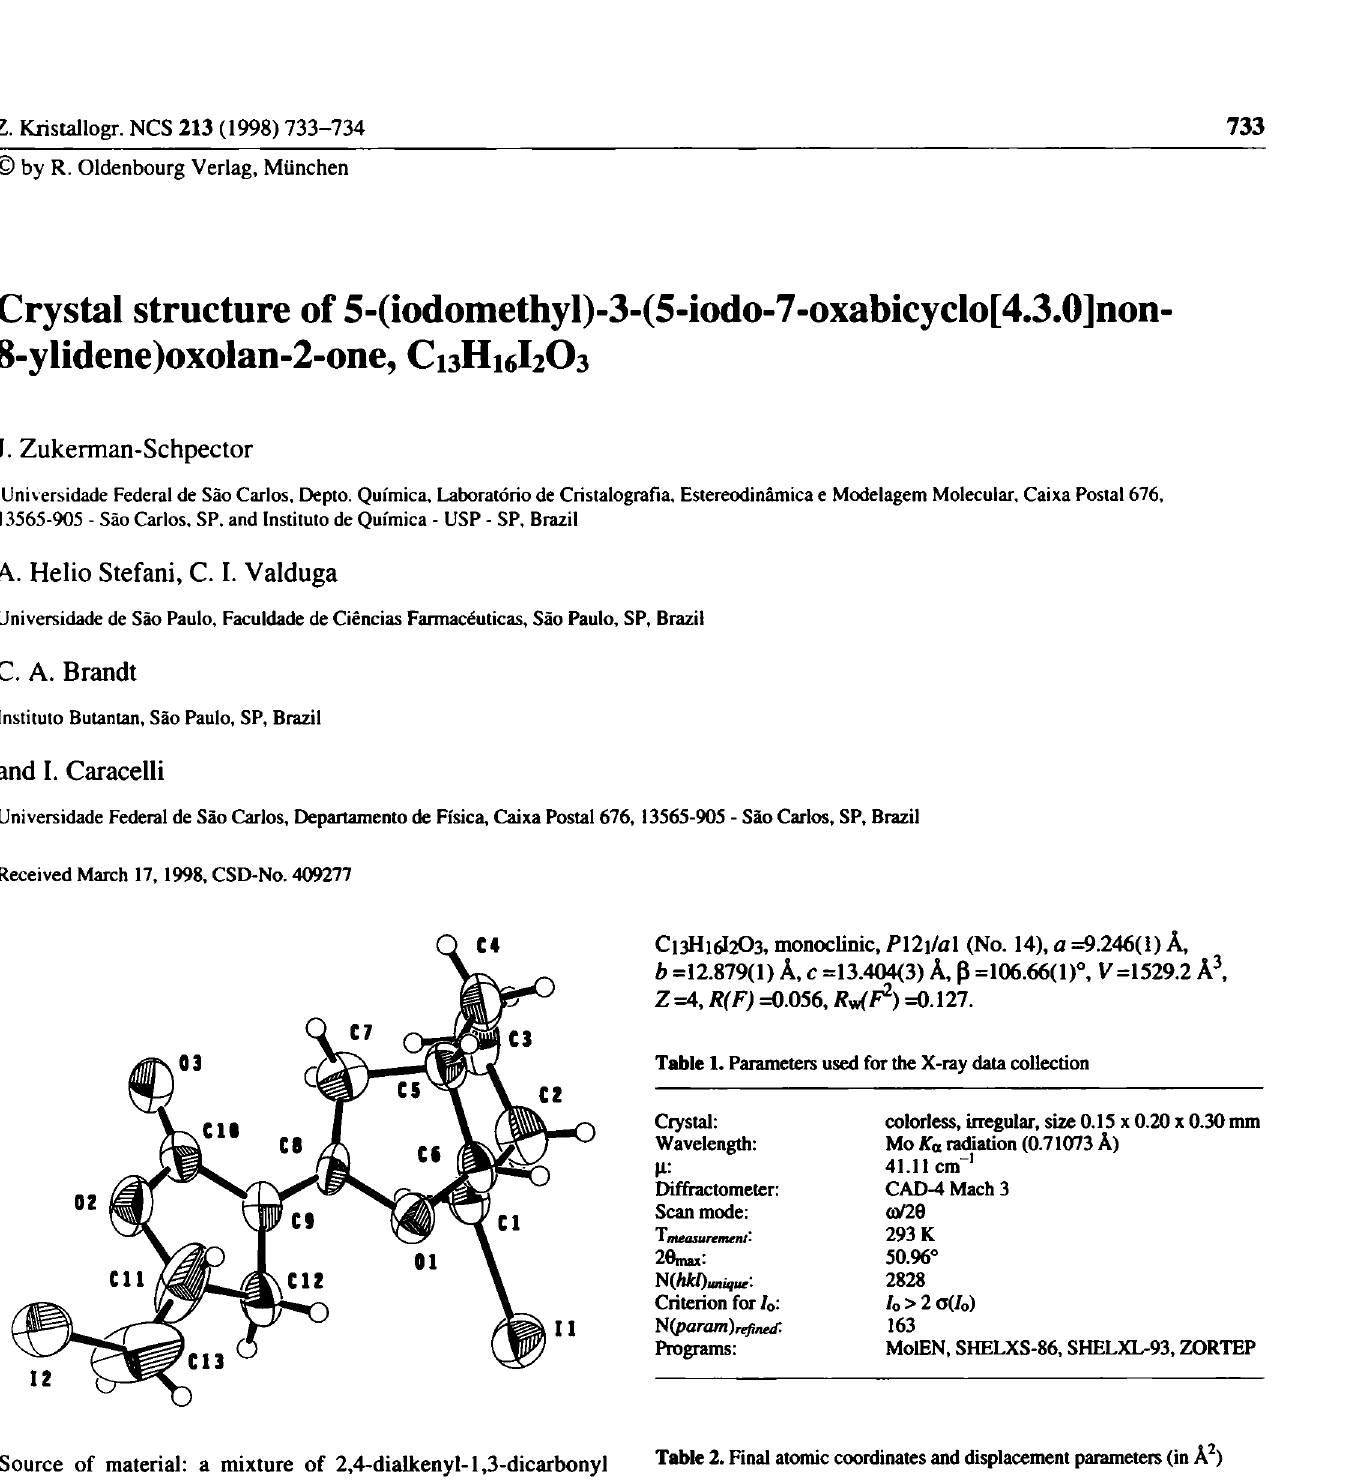
Table 2. Final atomic coordinates and displacement parameters (in Â^)